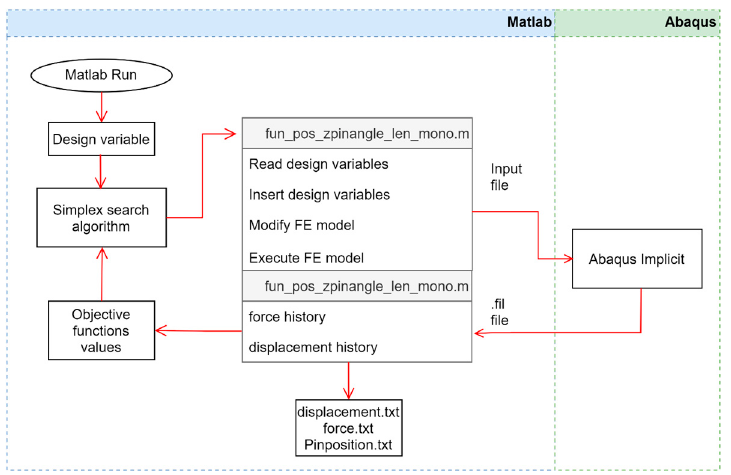
Figure 1. Scheme for the optimization routine with simplex search algorithm in Matlab ® and ABAQUS ® .